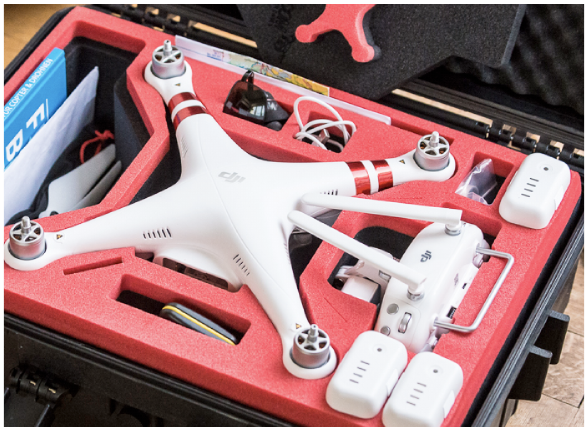
Figure 1. DJI “Phantom 3 Advanced” OTS quadro copter system in the MC case system.